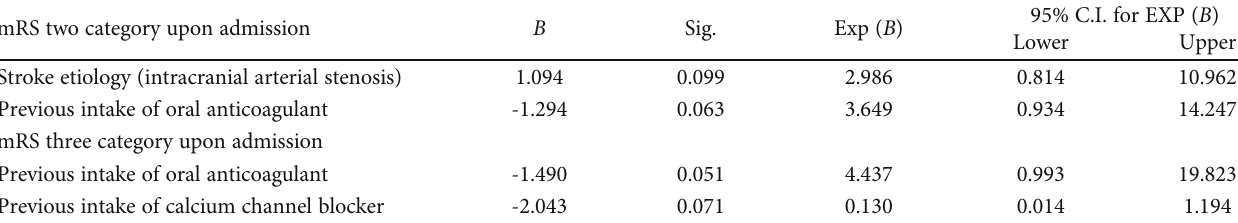
Table 5: Binary logistic regression taking mRS score at admission as the dependent variable and sociodemographic factors, past medical, and medication history as independent